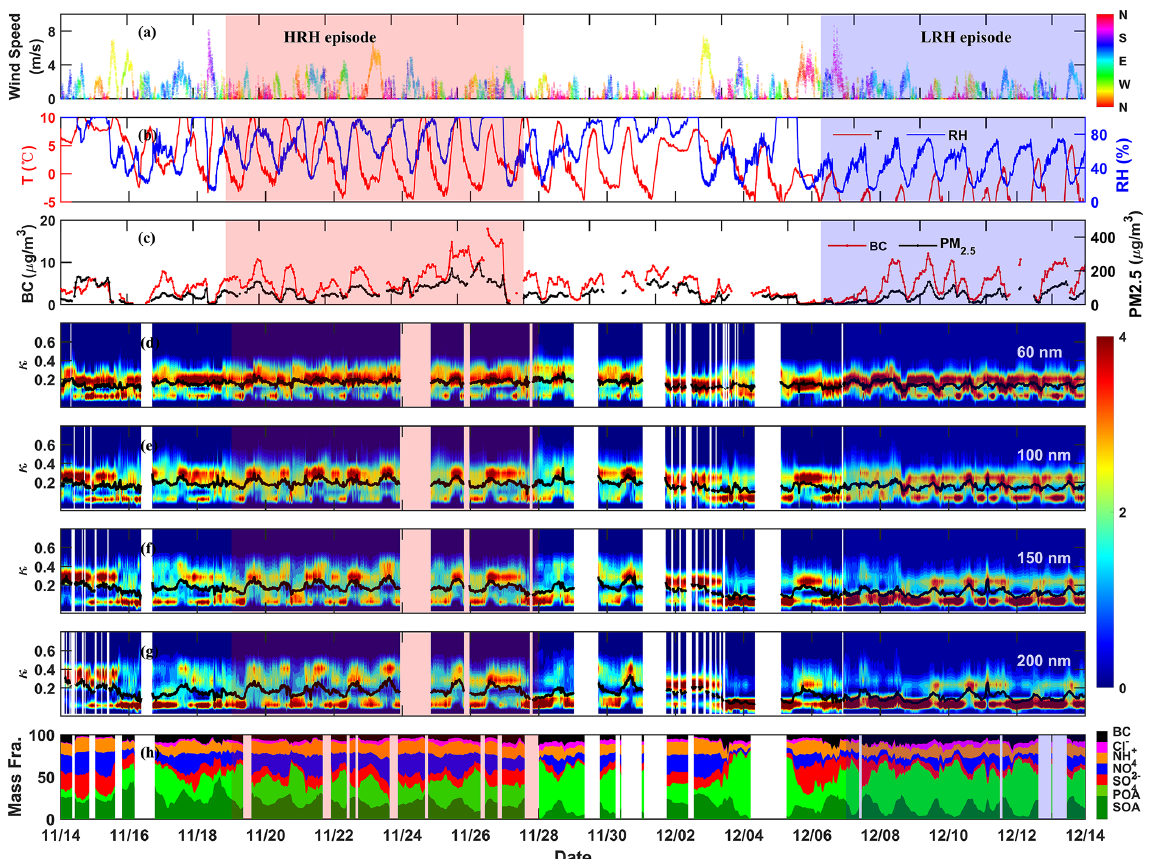
Figure 1. Time series of (a) wind speed and direction; (b) temperature and relative humidity; (c) PM 2 . 5 and BC mass concentrations; (d–g) the hygroscopicity parameter ( κ ) probability density function ( κ -PDF) for particles at dry sizes of 60, 100, 150, and 200nm (the black line is the averaged hygroscopicity parameter κ for particles at each size); and (h) mass fractions of the PM 1 chemical components during this field